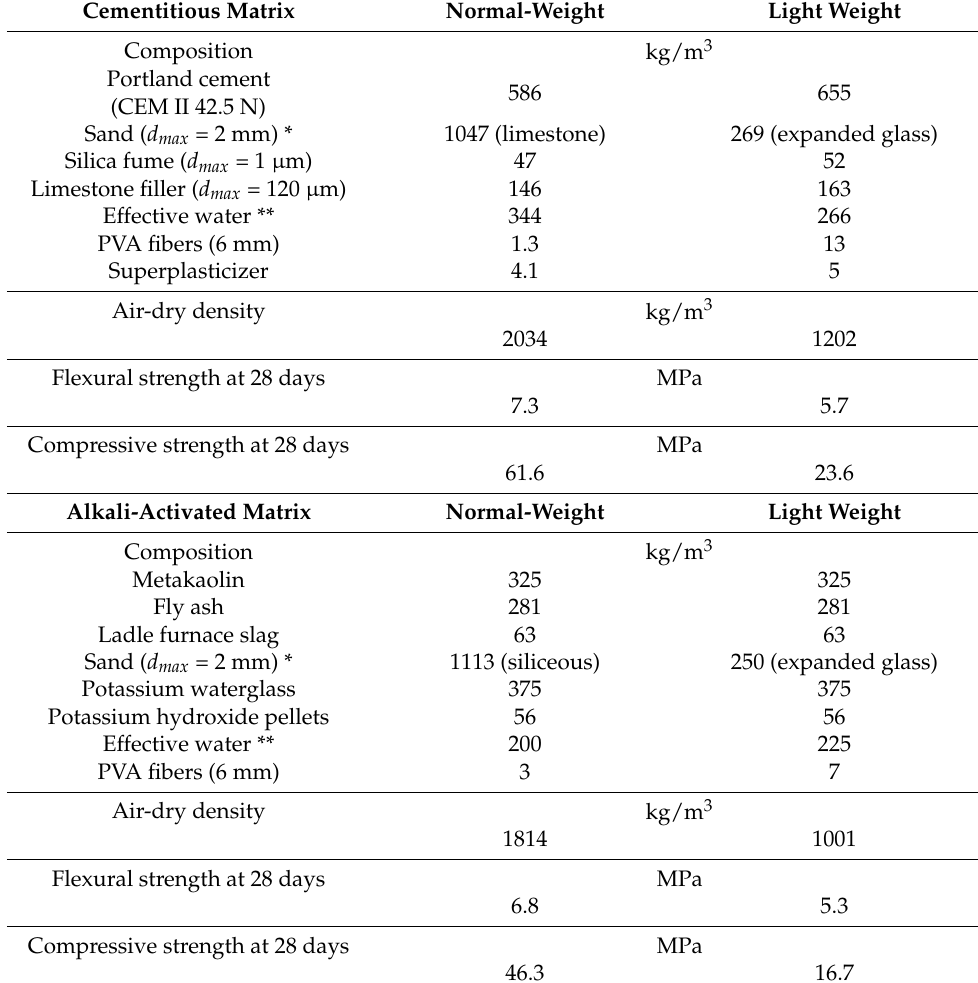
Table 1. The composition, air-dry density, and mechanical characteristics of matrices. Cementitious